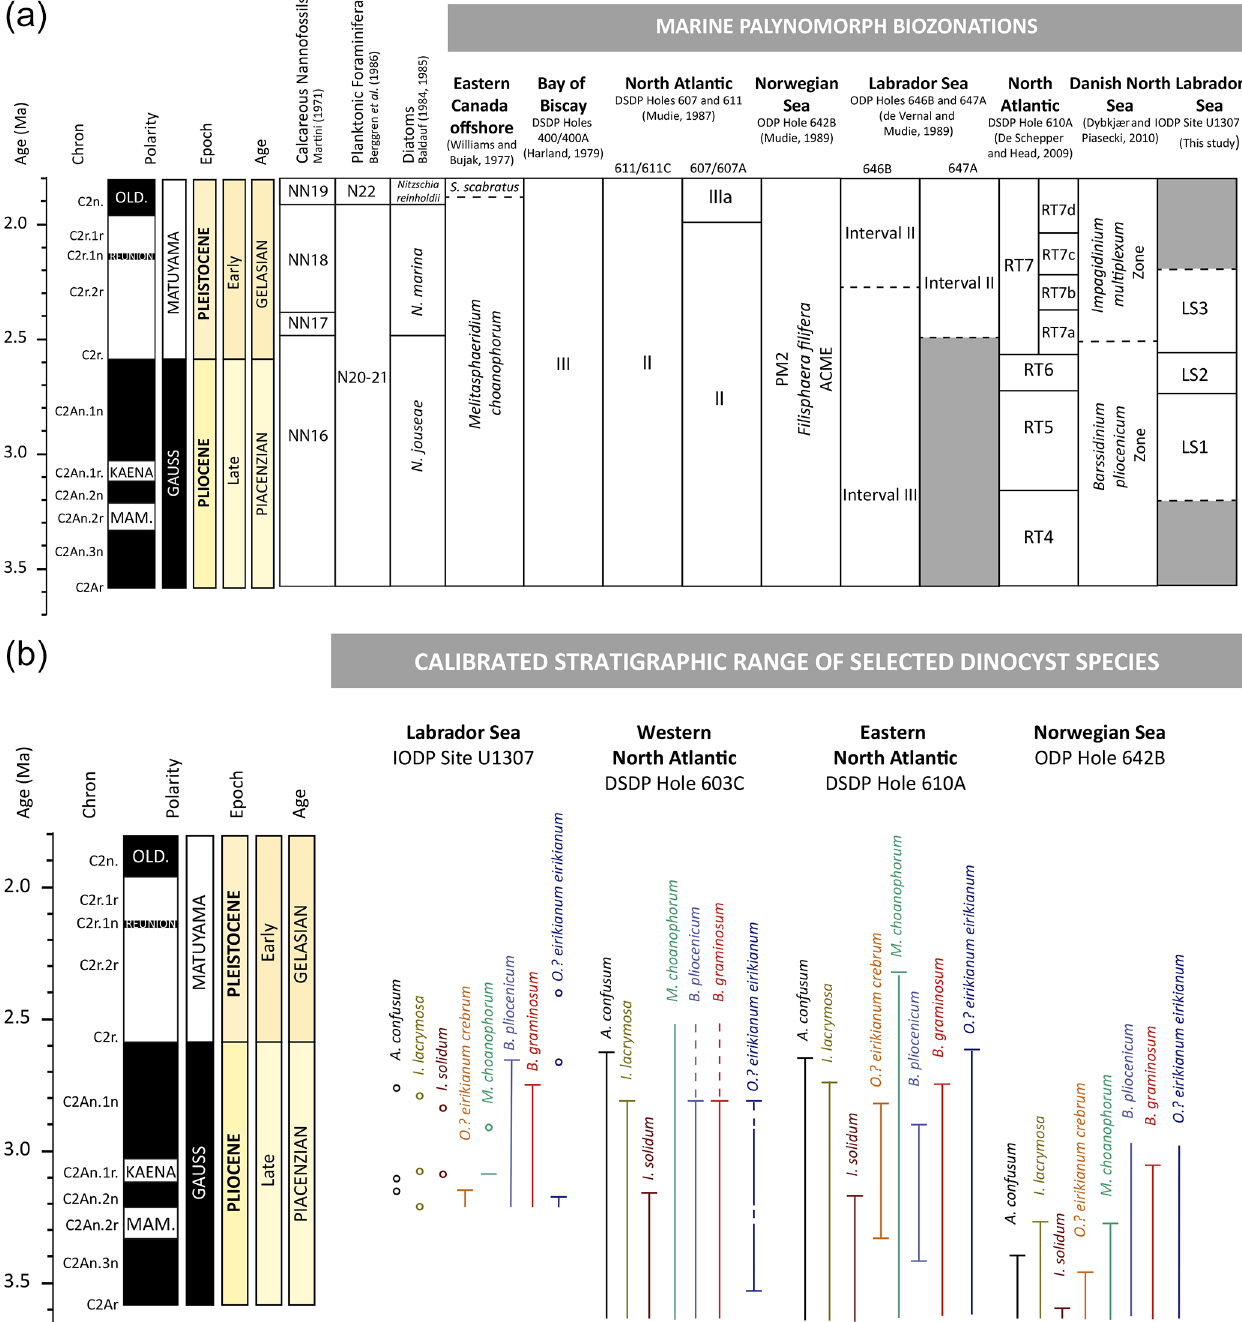
Figure 4. (a) Late Pliocene–Early Pleistocene dinocyst biozonation schemes from different locations in the North Atlantic. (b) Adapted from De Schepper et al. (2017). Late Pliocene dinocyst extinction events in the Labrador Sea (this study), the western North Atlantic (DSDP Hole 603C; Head and Norris, 2003; Martin J. Head, unpublished data), eastern North Atlantic (DSDP Hole 610A; De Schepper and Head, 2008a, b, 2009) and the Norwegian Sea (ODP Hole 642B; De Schepper et al., 2015,